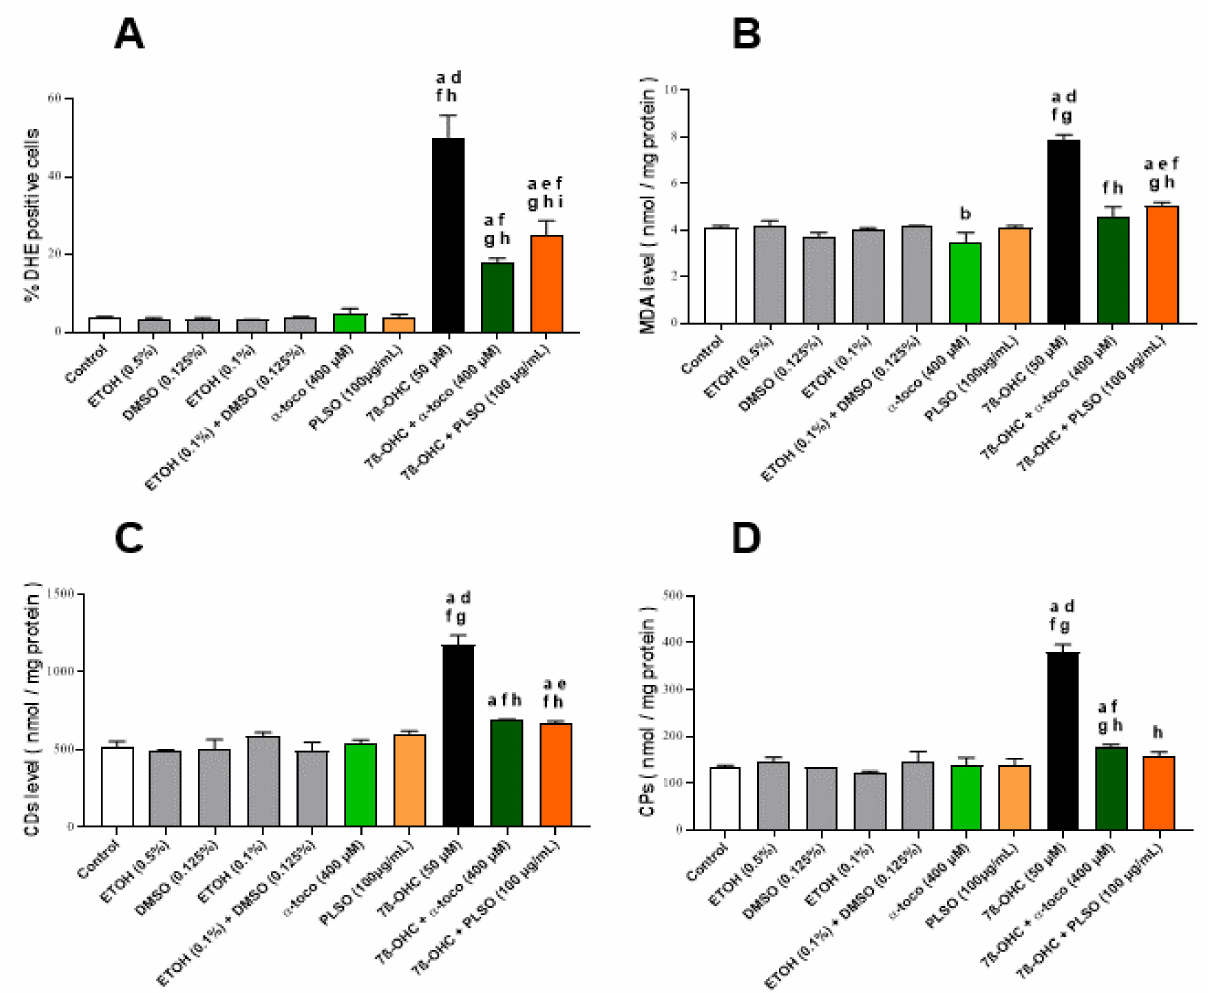
Figure 2. Effect of Pistacia lentiscus L. seed oil (PLSO) on 7 β -hydroxycholesterol-induced overproduction of reactive oxygen species (ROS) and lipid and protein oxidation products in C2C12 cells . C2C12 cells were incubated for 24 h with or without 7 β -OHC (50 µ M) in the presence or absence of PLSO (100 µ g/mL) or α -tocopherol (400 µ M). ROS overproduction was measured by flow cytometry after staining with dihydroethidium (DHE) ( A ). Lipid and protein oxidation products were determined with malondialdehyde (MDA) ( B ), conjugated dienes (CDs) ( C ) and carbonylated proteins (CPs) levels ( D ). Data are presented as the mean ± SD of two independent experiments performed in tripli- cate. A multiple comparative analysis between the groups, taking into account the interactions, was carried out using an ANOVA test followed by a Tukey’s test. A p -value less than 0.05 was considered statistically significant. The sta- tistically significant differences between the groups, which are indicated by different letters, take into account the ve- hicle used. a: comparison versus control; b: comparison versus ETOH (0.5%); c: comparison versus DMSO (0.125%); d: comparison versus ETOH (0.1%); e: comparison versus (ETOH (0.1%) + DMSO (0.125%)); f: comparison versus α -toco (400 µ M); g: comparison versus PLSO (100 µ g/mL); h: comparison versus 7 β -OHC (50 µ M); i: comparison versus 7 β -OHC (50 µ M) + α -toco (400 µ M). No significant differences were observed between the untreated (control) and vehicle- treated